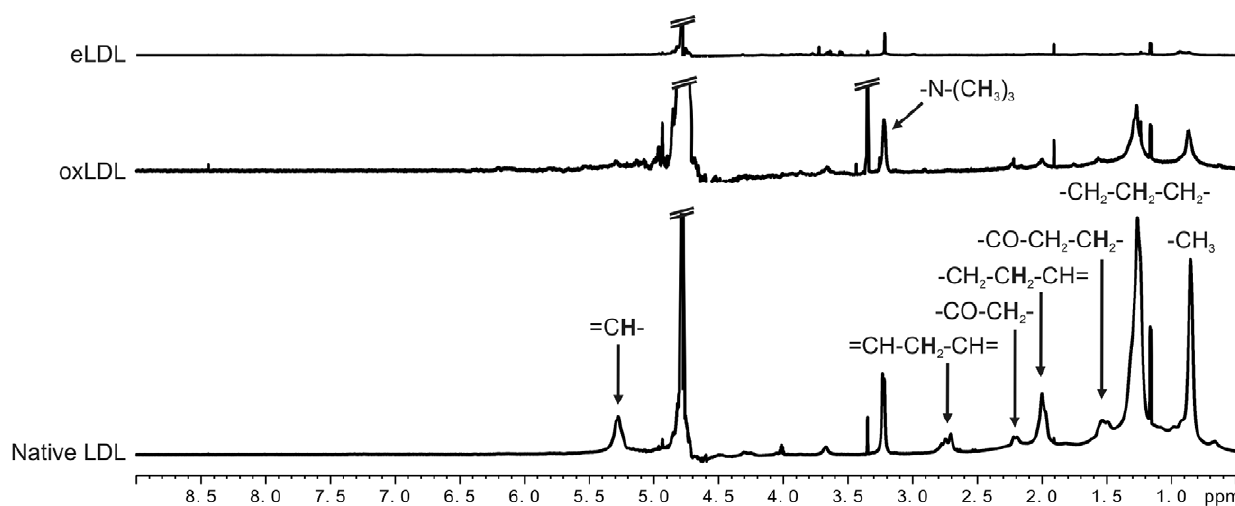
Figure 1. Representative NMR spectra of native LDL, oxLDL and eLDL. (Bottom) Native LDL gave rise to lipid signals predominantly of methyl and methylene protons of fatty acid chains. (Center) NMR spectra of oxLDL showed substantially decreased lipid signals compared to native LDL. (Top) eLDL spectrum: resonances of lipids were virtually absent. Instead, amino acid signals and mobile protein peaks were observed. NMR spectral parameters: 800 MHz spectrometer frequency, 1D-NOESY pulse sequence with water presaturation (noesygppr1d), 7.7 s repetition time, 10 ms mixing time, temperature: 25 u C. Spectral annotation according to dominant contributions to NMR signals. Spectra were normalized to the concentration of apoB-100 determined prior to oxidation or modification. Each LDL subtype was investigated on the basis of at least three replicates from different donors, N=3 except for ‘‘oxLDL’’ (N=2).